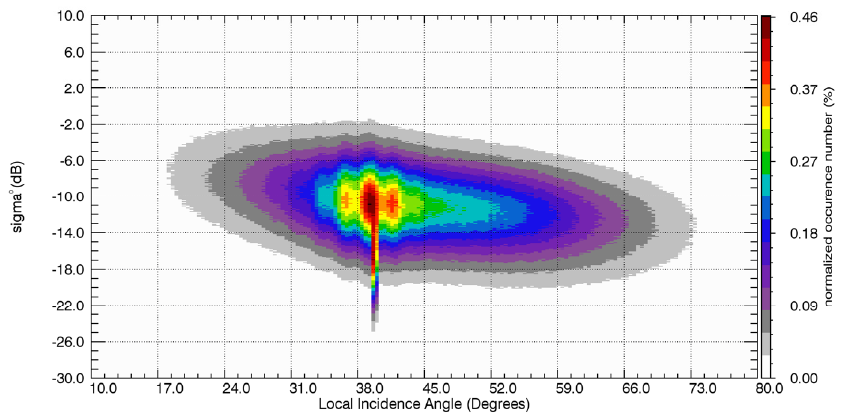
Figure 14. Backscattering coefficient σ 0 [dB] without the compensation of topography-induced distortions vs. local incidence angle [degree].